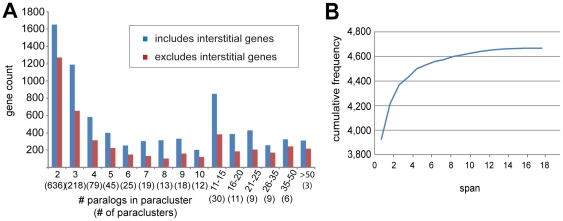
Paracluster sizes.(a) Total gene count in paraclusters as a function of paracluster size measured as the number of paralogs in each paracluster. Gene counts include (blue) and exclude (red) interstitial genes. The parenthetical text provides the number of paraclusters having the corresponding size. (b) Cumulative frequency distribution of distances (spans) between genes sharing the same paracluster.